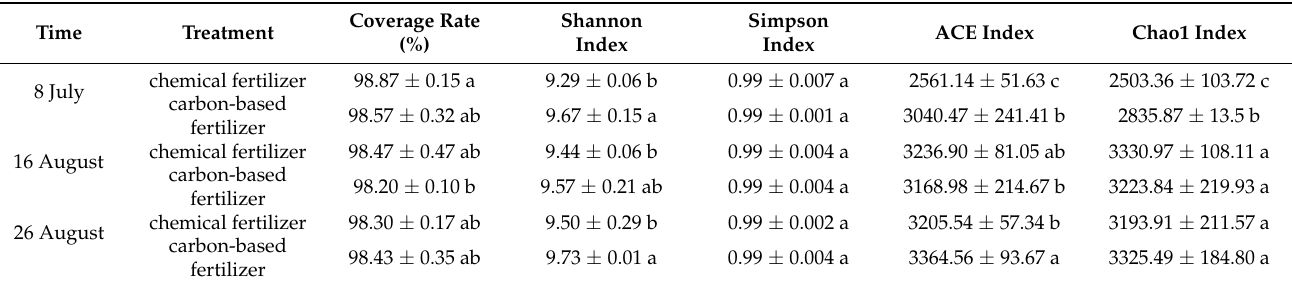
Table 6. α -diversity of soil bacteria treated with carbon-based fertilizer and chemical